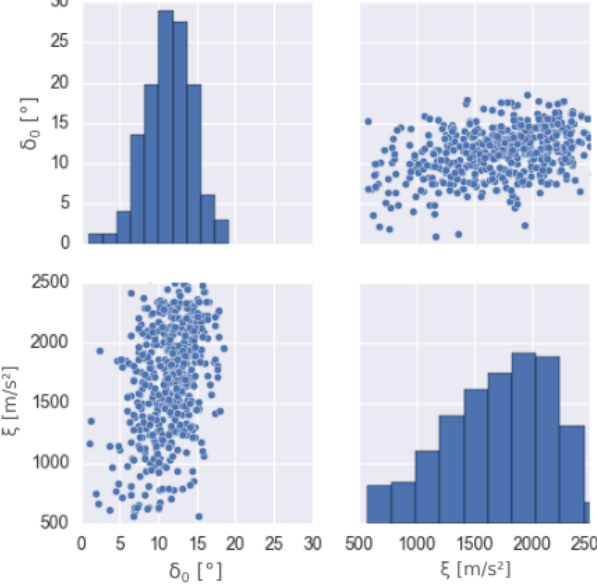
Figure 2. Scatterplots and histograms (counts are re-scaled to the maximum count for a better visibility) for the Monte Carlo sample of the posterior distribution θ pred